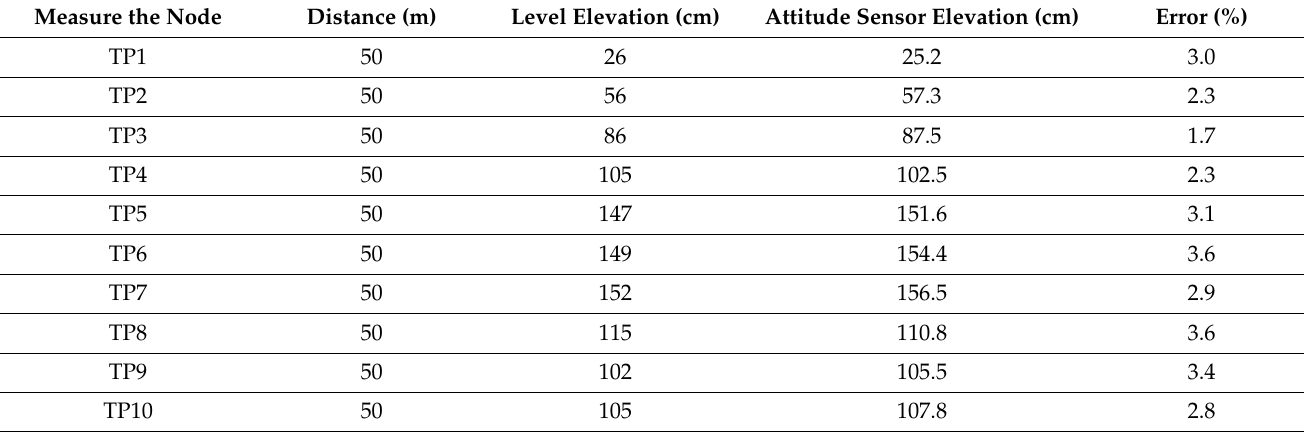
Table 1. Elevation data of a road in Jining, Shandong